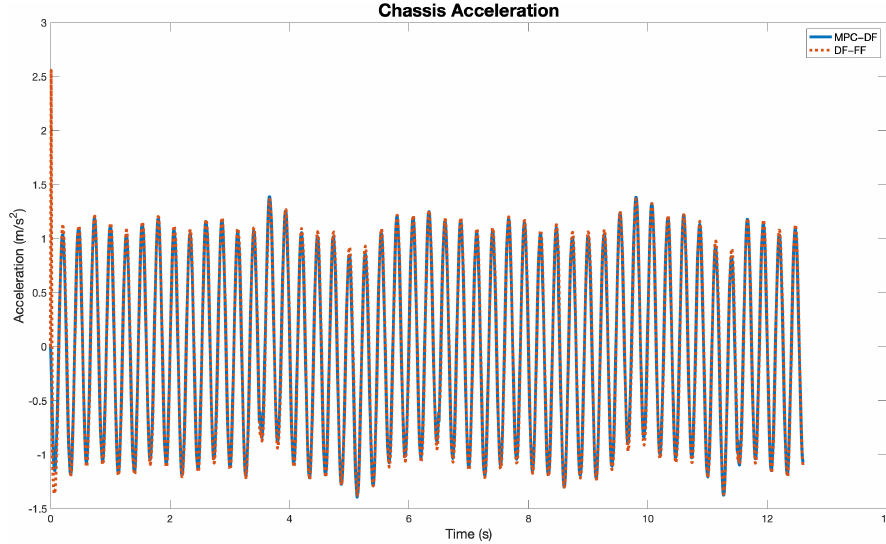
Figure 5. Chassis Acceleration (Blue–MPC-DF,